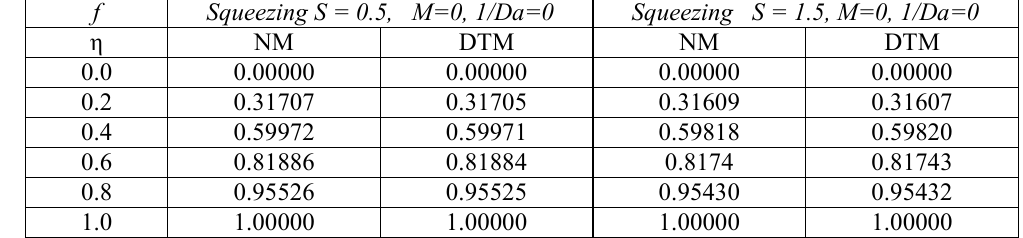
Results of NM and DTM for small squeezing number in the absence of magnetic field.